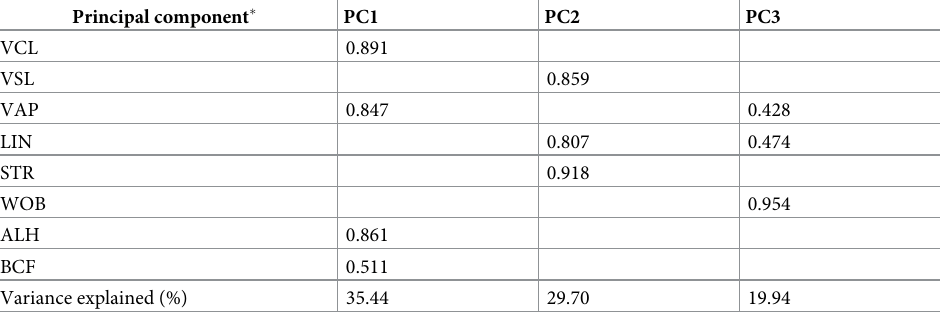
Total variance explained = 85.08%. � Expresses the more important variables in each PC. Only eigenvectors > 0.4 are presented. VCL: Curvilinear velocity; VSL: Straight-line velocity; VAP: Average path velocity; LIN: Linearity of forward progression; STR: Straightness; WOB: Wobble; ALH: Amplitude of lateral head displacement; BCF: Beat-cross